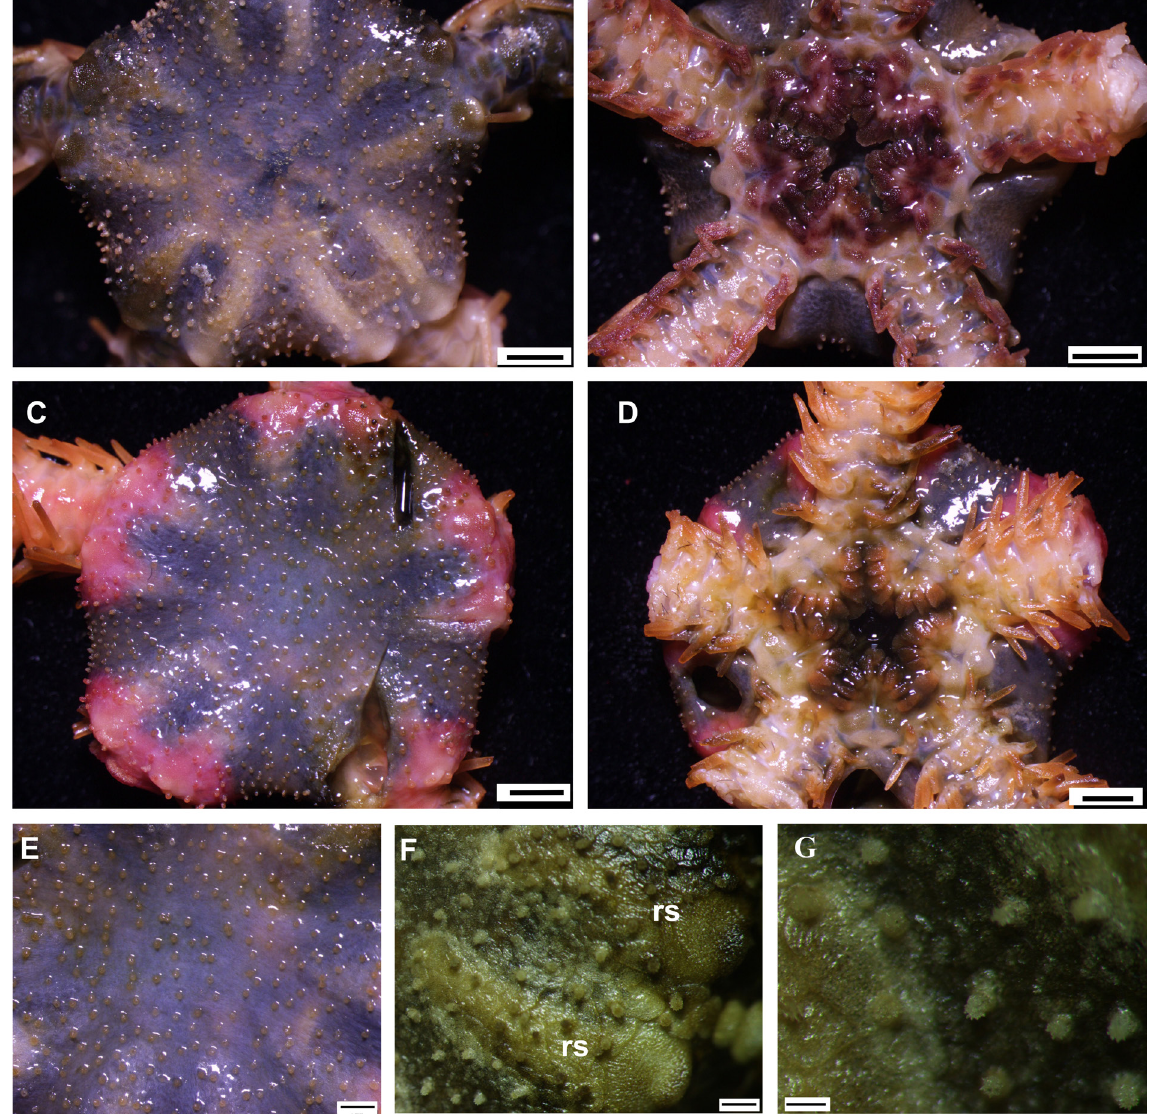
Fig. 20. Ophientrema scolopendrica (Lyman, 1883) (A–B, E–G = IDSSE EEB-SW0020; C–D = IDSSE EEB-SW0021). A, C . Dorsal disc. B, D . Ventral disc. E . Center of dorsal disc. F . Lateral disc. G . Granules on the disc. Abbreviation: rs = radial shield. Scale bars: A–D = 2 mm; E = 1 mm; F–G = 500 µm. (F and G taken of well-dried